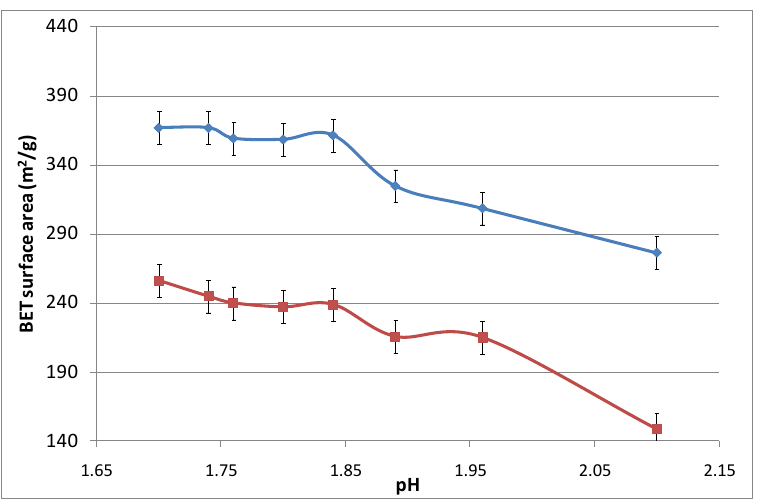
Figure 6. Surface area of samples as a function of